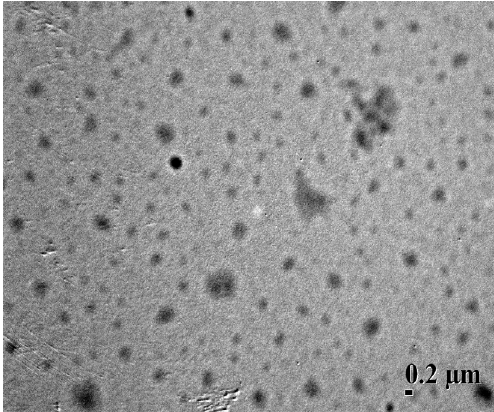
Figure 4. Transmission electron microscopy (TEM) image of Dex-TOS-3/Dox micelles (×10000).